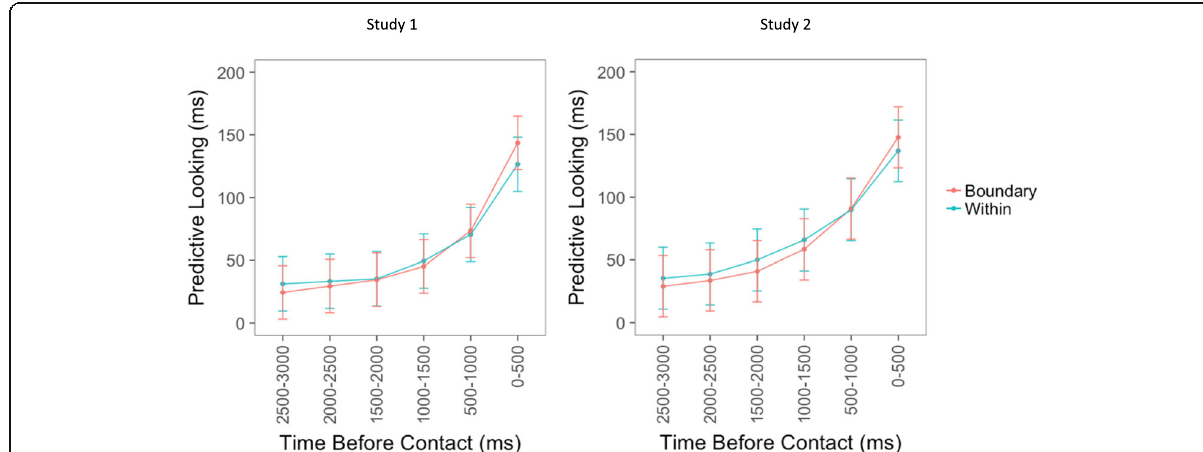
Fig. 5 The panel on the left displays the results of the linear mixed effects model for the first study. The y-axis displays the beta values representing the amount of time participants spent looking at the target object during each of the six 500-ms bins. The panel on the right displays the same information for the second study. The x-axis for both figures displays the six bins, where the leftmost bin on each x-axis represents the time farthest away from contact and the rightmost bin represents the time closest to contact. The red line displays predictive looking collapsed across boundary types (fine, coarse, both fine and coarse). The blue line displays predictive looking when there were no event boundaries nearby (within events). Error bars depict 95% confidence intervals calculated based on between-subjects